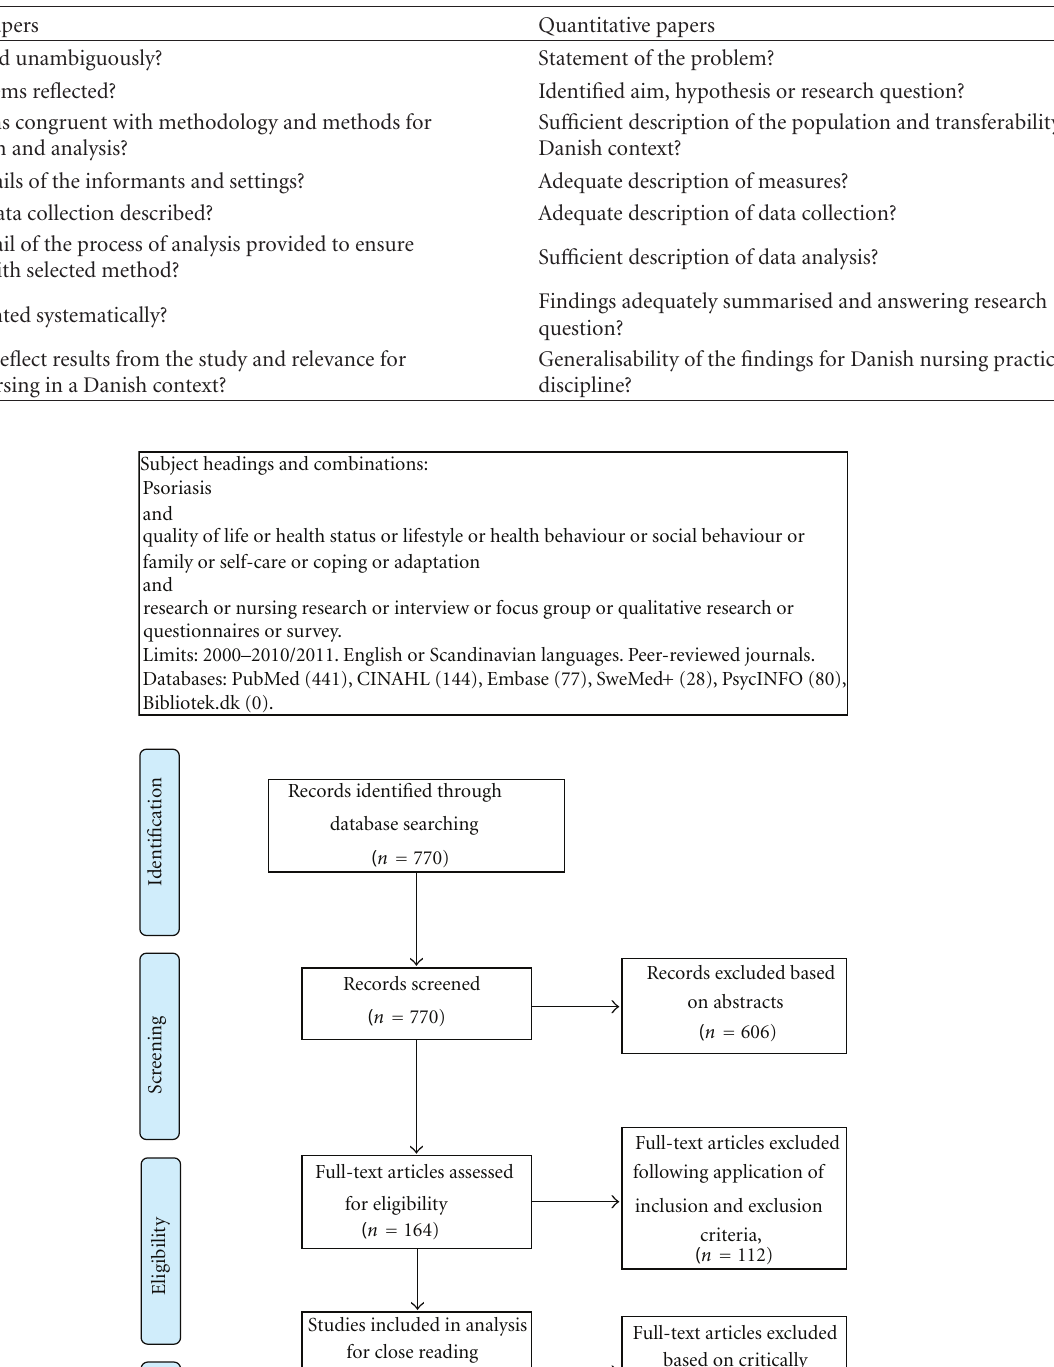
Table 1: Criteria for assessment of identified papers.